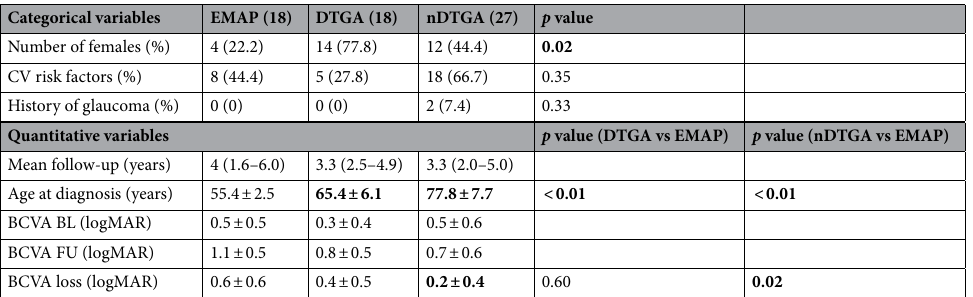
Table 1. Clinical Characteristics of extensive macular atrophy with pseudodrusen-like appearance, diffuse- trickling geographic atrophy and geographic atrophy. Categorical variables expressed as number (%). Normally distributed quantitative data expressed as mean ± standard deviation. Non-parametric quantitative data expressed as median (Interquartile range 25–Interquartile Range 75). EMAP Extensive macular atrophy with pseudodrusen-like appearance; DTGA Diffuse-trickling geographic atrophy; nDTGA non-diffuse-trickling geographic atrophy; CV Cardiovascular; BCVA Best Corrected Visual Acuity; BL Baseline; FU Follow-up. p values of Chi-square test for categorical variables. p values of Tukey HSD post-hoc test for ANOVA for quantitative variable comparison with EMAP were reported if three-group comparison with ANOVA resulted statistically significant ( p < 0.05). Significant values are in bold.